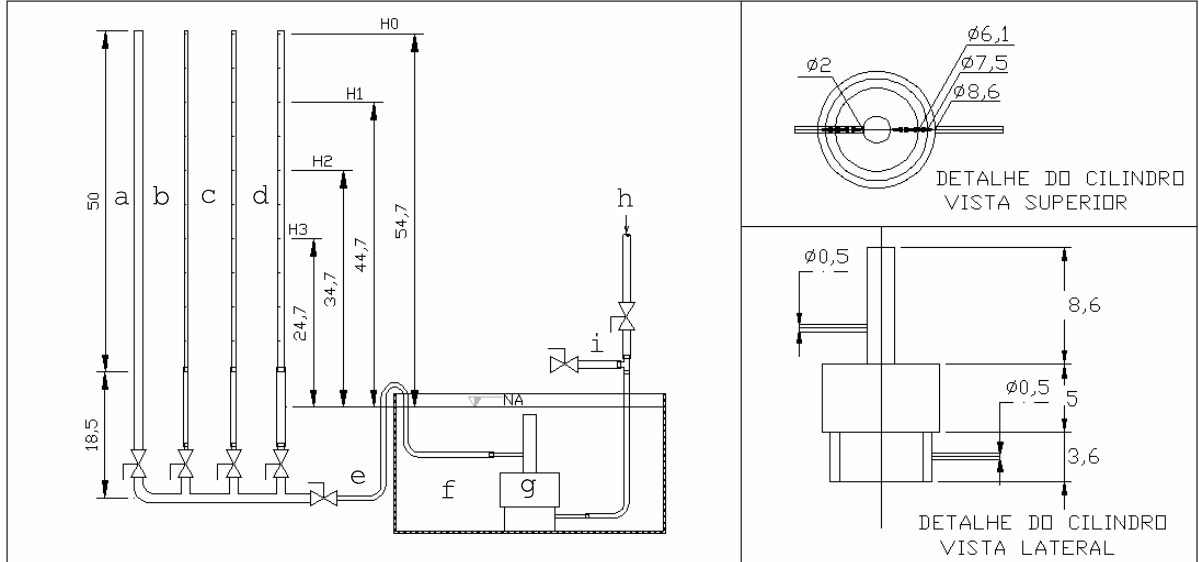
Figura 1. Permeâmetro de carga decrescente. Tubulação de alimentação de água (a); tubos de vidro graduados, com diâmetro interno de 3,95 mm (b), 5,91 mm (c) e 10,02 mm (d); segmento do duto de PVC flexível que alimenta a cúpula com água (e); tanque preenchido com água (f); cilindro ou cúpula onde é inserida a amostra de solo (g); segmento do duto de PVC flexível que conduz ar pressurizado à borracha de vedação do interior da cúpula (h); duto de despressurização (i). Mais ilustrações e detalhes da montagem do permeâmetro estão disponíveis na página